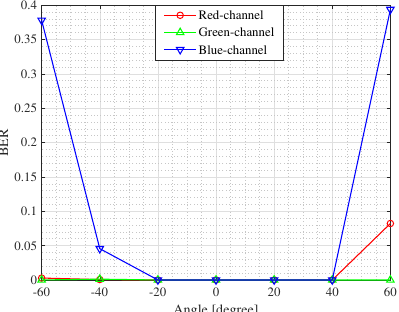
Figure 17. BER performance according to display-camera